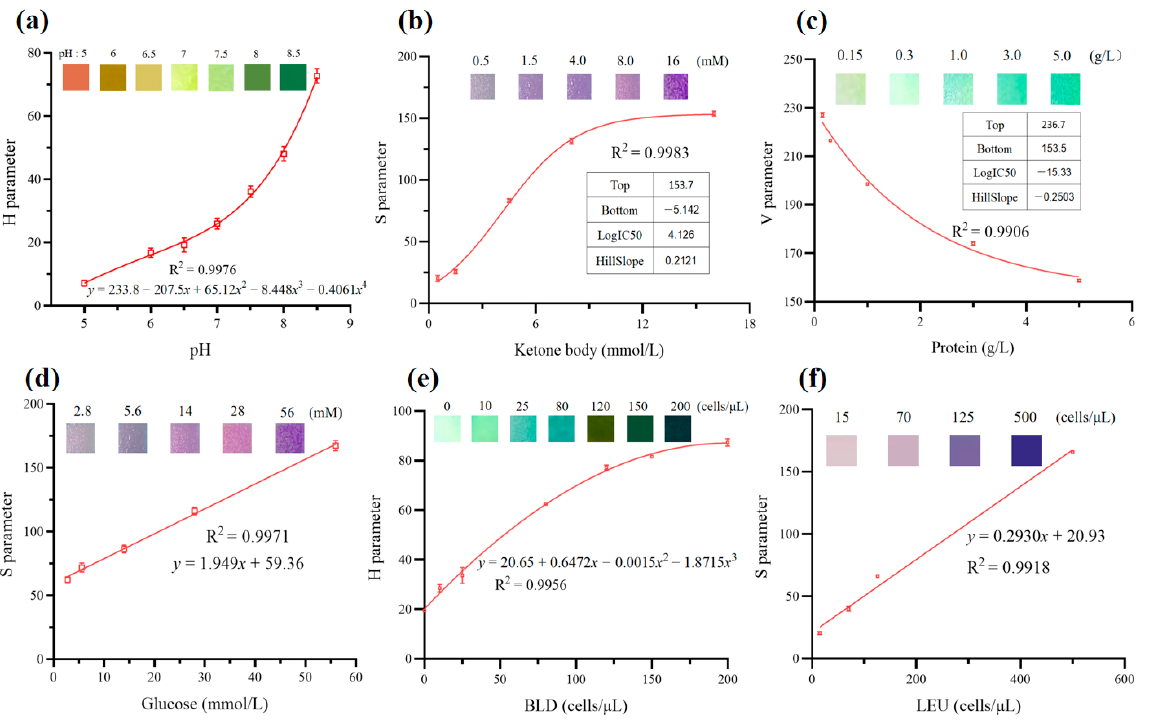
Figure 6. Measurement of the HSV values for ( a ) pH, ( b ) ketone bodies, ( c ) protein, ( d ) glucose, ( e ) occult blood, and ( f ) leukocytes with varying concentrations.